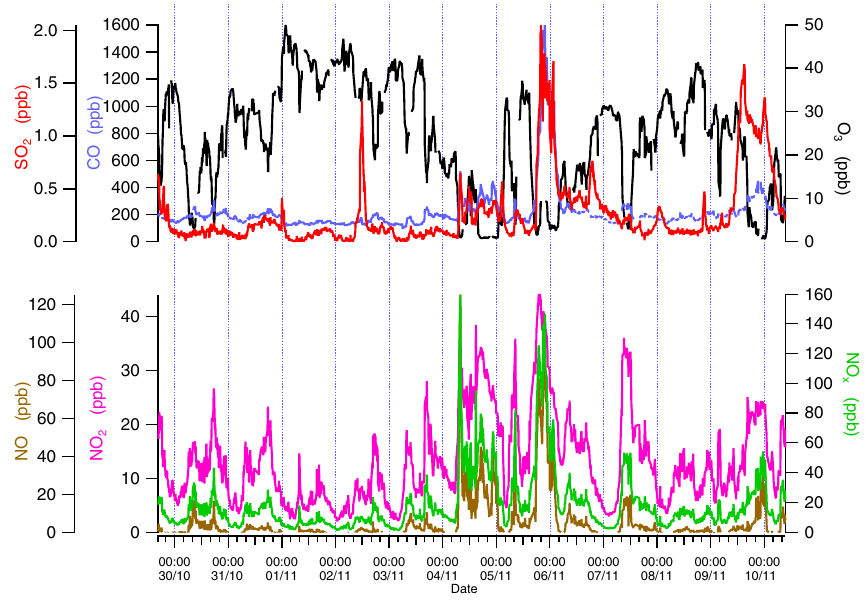
Figure 2. Time series of gases measured at Whitworth observatory.